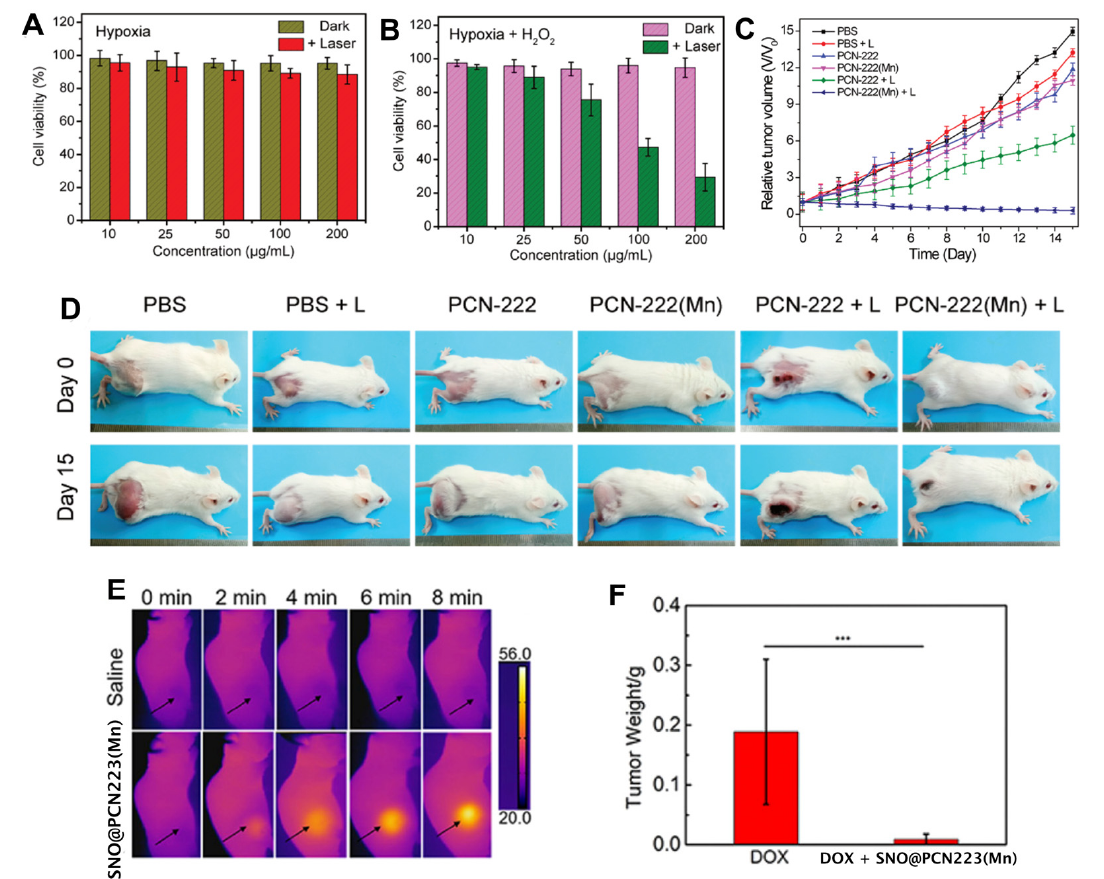
Figure 7. MTT assay of the 4T1 cell viability after incubation with different concentrations of ZrPCN- 222(Mn) and irradiation by a 660 nm laser for 8 min under ( A ) hypoxic conditions without H 2 O 2 and ( B ) under hypoxia in the presence of H 2 O 2 (100 µM). ( C ) Time-dependent relative tumour volumes and mice body weights for different treatment groups. ( D ) Photographs of mice before treatment and on the 15th day after treatment. ( E ) in vitro IR thermal photos of saline and SNO@ZrPCN- 223(Mn) under NIR laser irradiation. ( F ) Tumour weight after DOX chemotherapy and SNO@ZrPCN-223(Mn) combined with DOX chemotherapy (*** p < 0.001). Reprinted/adapted with permission from Ref. [91,92] .